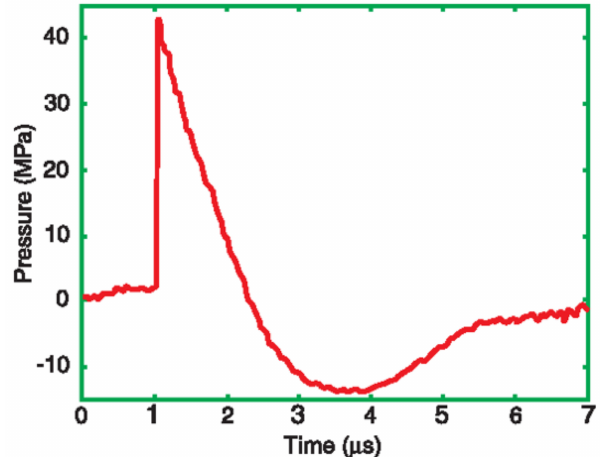
Figure 1. Schematic representation of a ballistic shockwave source